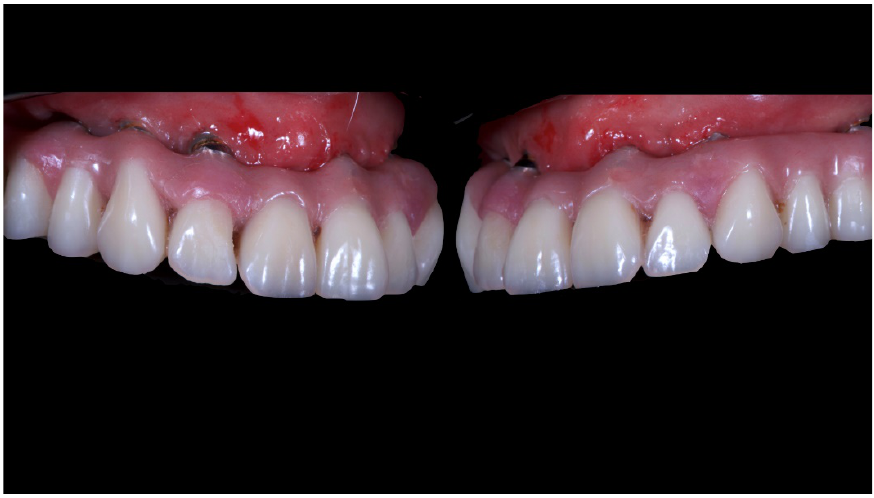
Figure 14. Final prosthesis with composite fillings made with pink and tooth-colored composite.